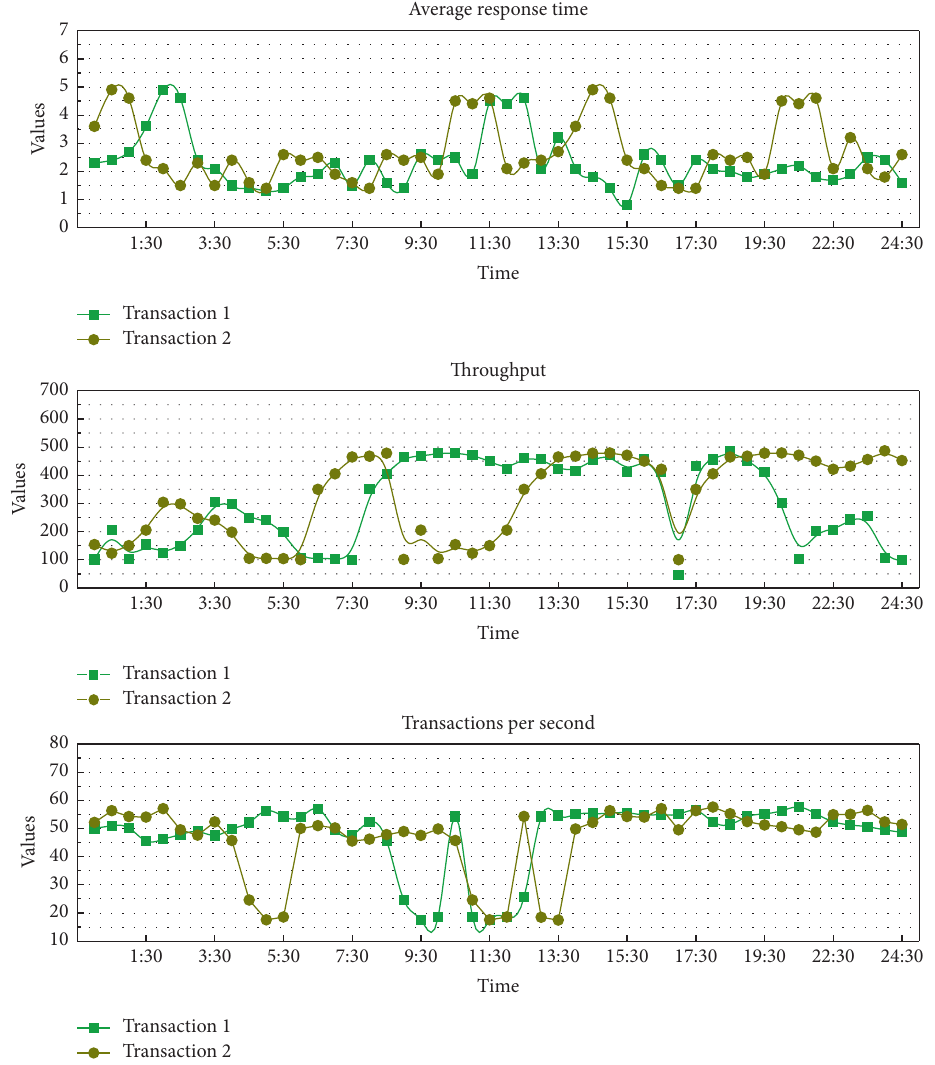
Figure 8: System orderliness measurement